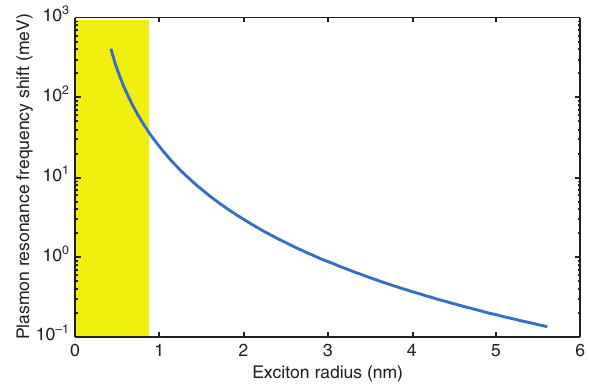
Figure 4: Upward shift of the “undressed LSP resonance” as a function of the exciton radius a . Shaded region indicates the range of excitonic radii at which the upward shift of LSP precludes its effective coupling to the